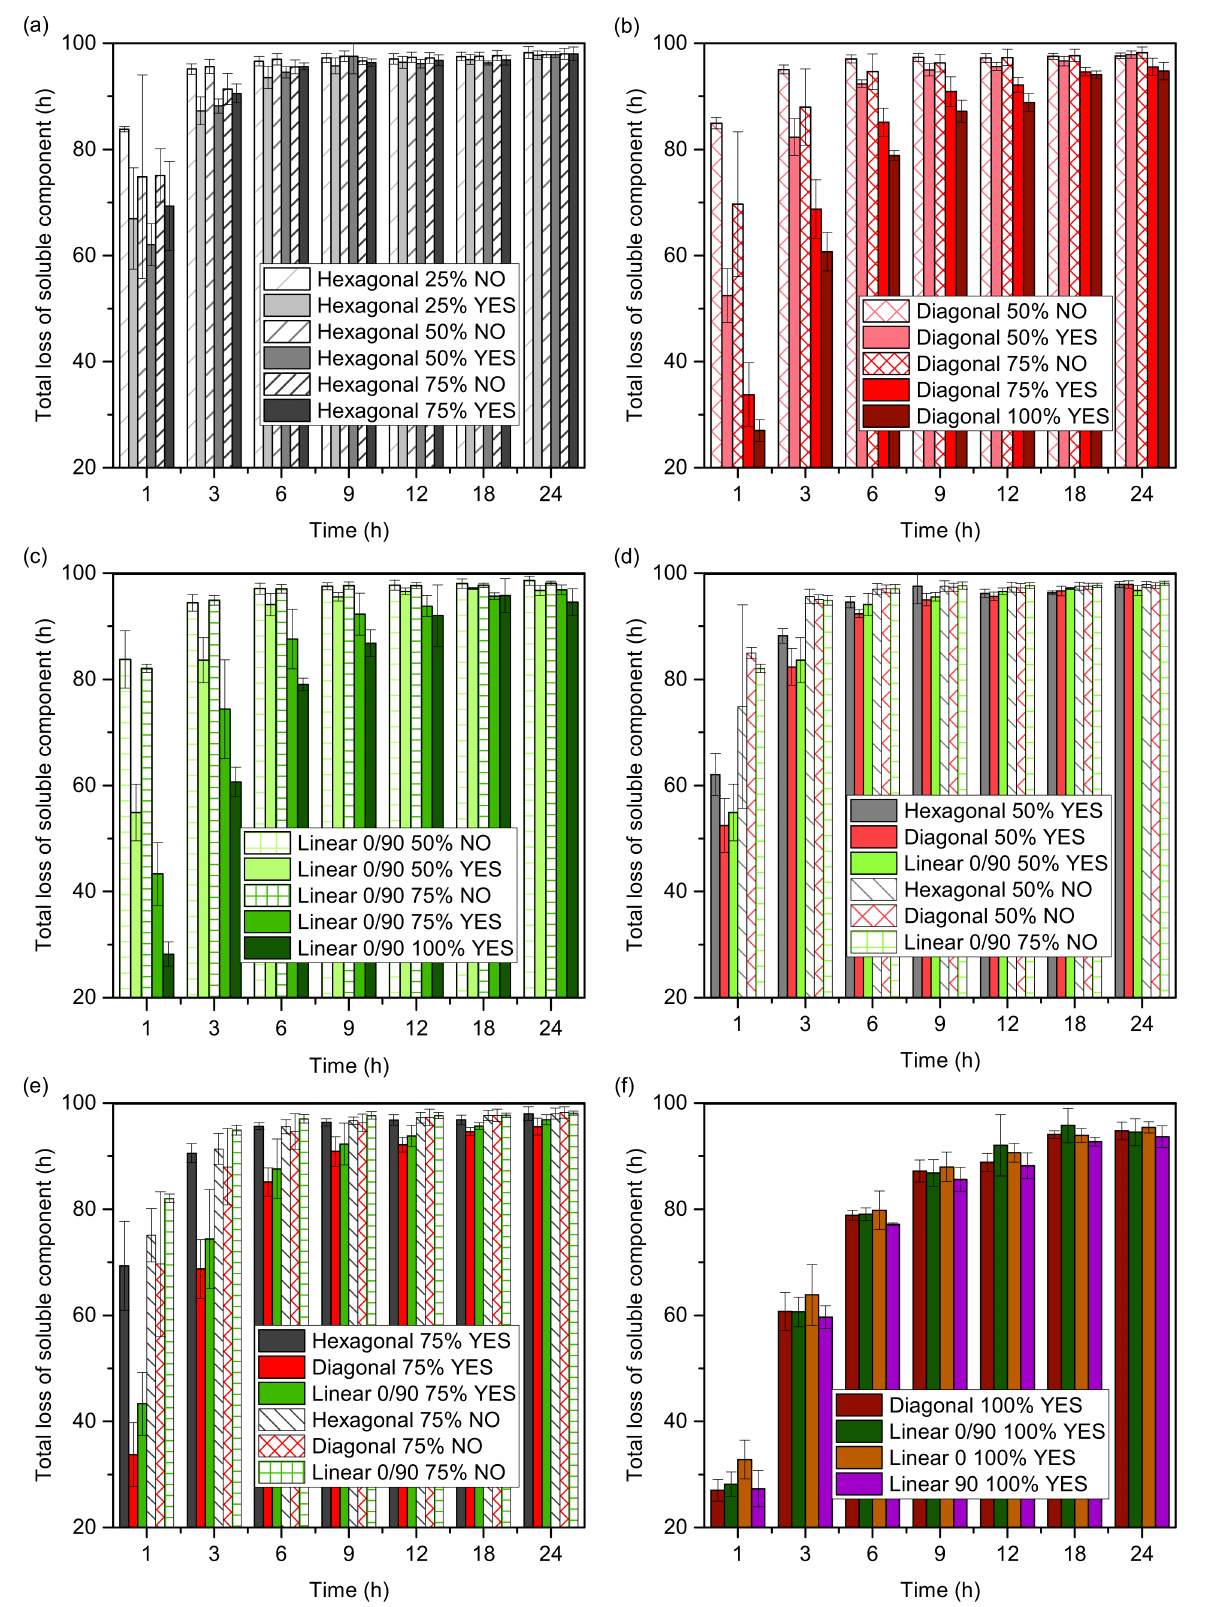
Figure 5. Debinding rate of printed specimens with different infill patterns and infill grades ( a ) hexagonal, ( b ) diagonal 45/45, and ( c ) linear 0/90, as well as different infill patterns but same infill grade, ( d ) 50%, ( e ) 75% and ( f )